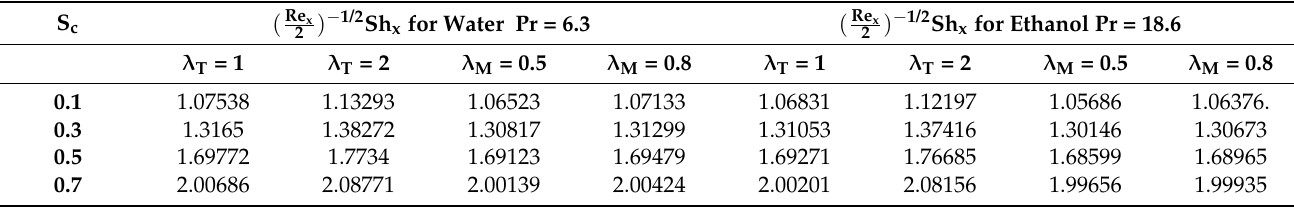
Table 4. Sherwood number for both fluids with β = 0.1, M = 1, γ = 0.2,A =